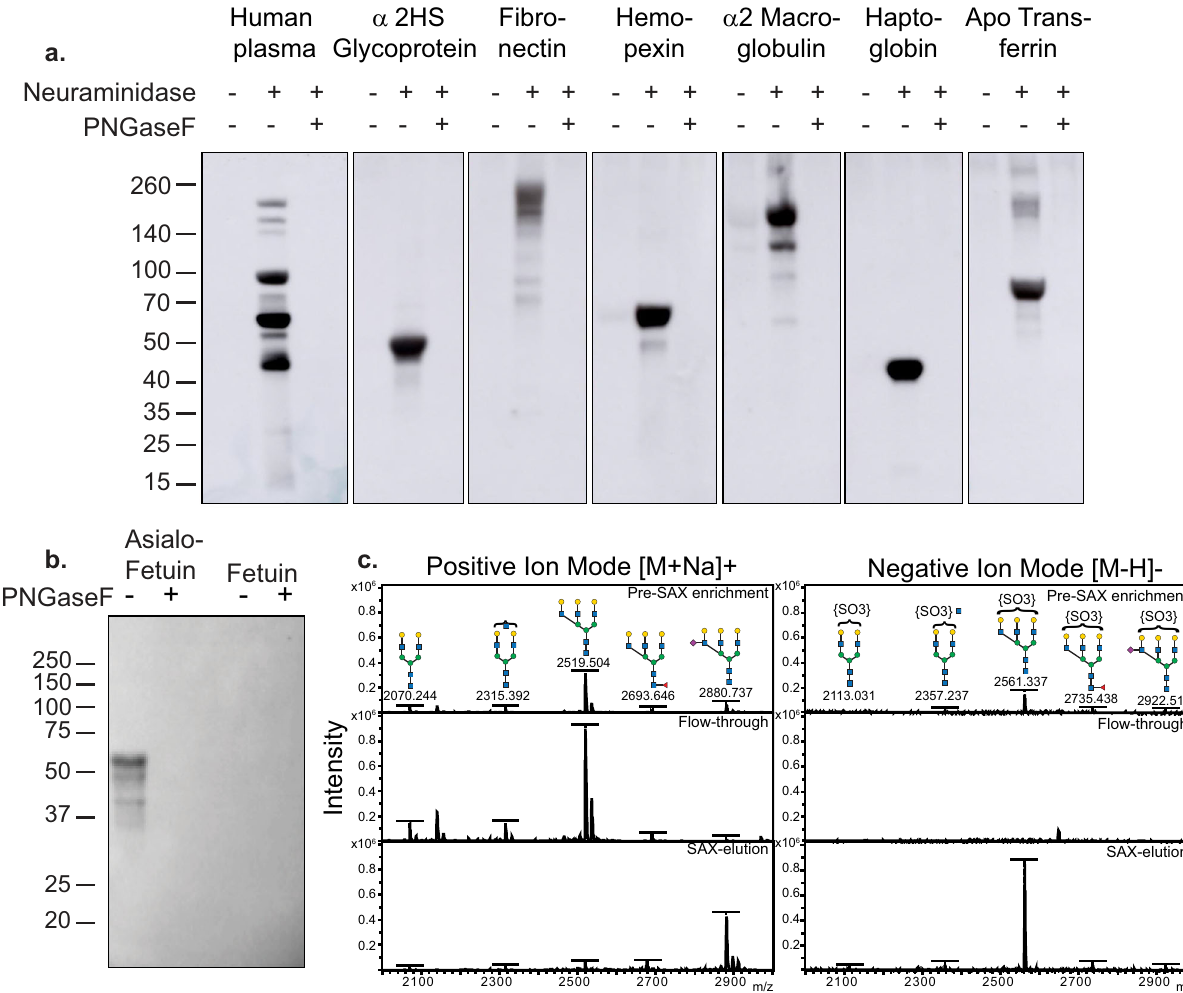
Fig. 5 Analysis of human plasma glycoproteins and bovine fetuin. a Western blot of normal human plasma and puri fi ed human serum glycoproteins reveal galactose-3-sulfate modi fi cation present on sialylated N-glycans. b Western blot of fetuin and asialofetuin identify the galactose-3-sulfate modi fi cation is present on N-glycans. c MALDI-TOF analysis in positive and negative ion mode of PNGaseF released N-glycans. The predominant peak containing the galactose-3-sulfate modi fi cation on a triantennary N-glycan enriched in the SAX-eluted fraction (negative